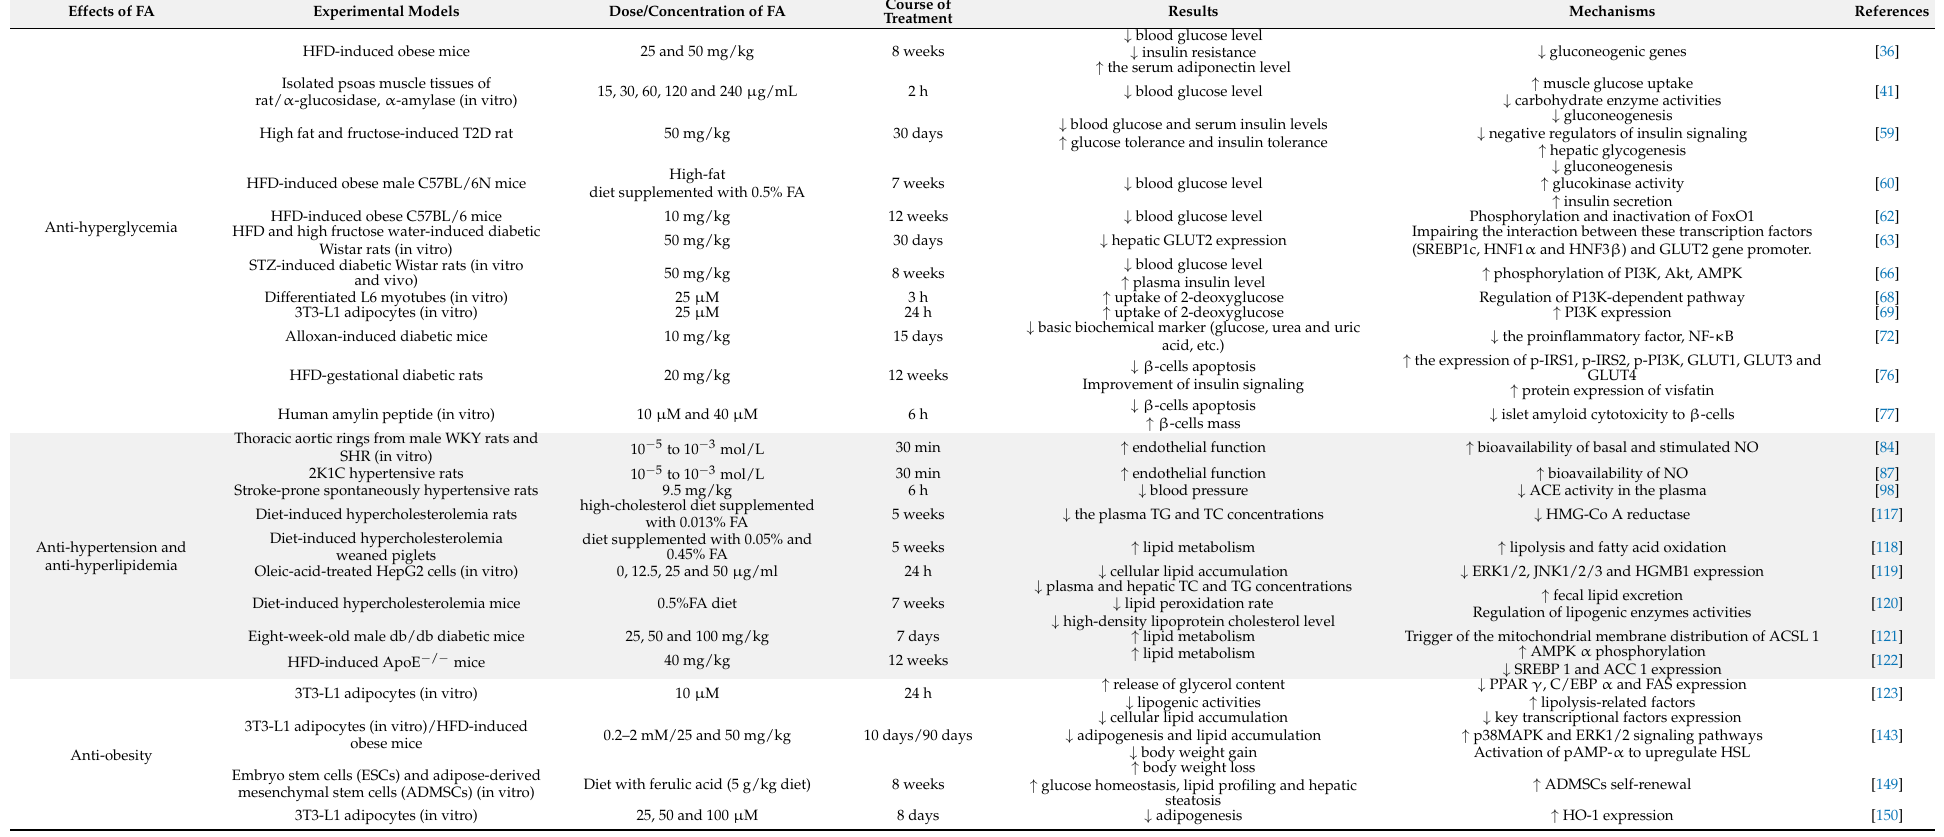
Table 1. Mechanisms of ferulic acid improving metabolic syndrome